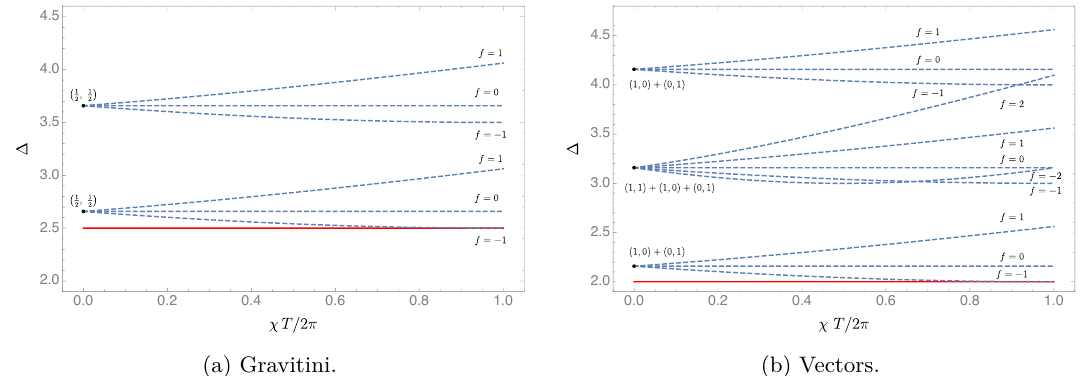
Figure 3 . Dimensions ∆ (dashed blue lines) of individual gravitino (left) and vector (right) states with flavour f in the spectrum on Family III, at KK levels ‘ = 0 , n = 1 , as functions of χ . The solid red lines stand at the massless threshold. At χ = 0 , the SO(4) representations from which the flavoured states branch down are